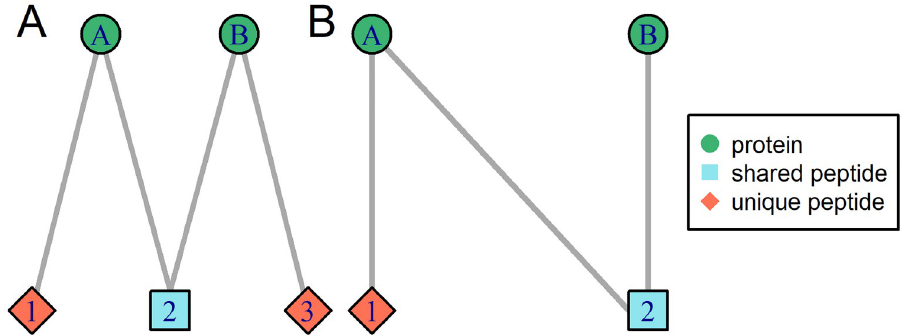
Fig 1. Examples of bipartite graphs depicting protein-peptide relationships. Protein nodes are shown as green circles and peptide nodes as red diamonds (unique to a protein node) or blue squares (shared between protein nodes). Each node may represent multiple protein accessions or peptide sequences. Unique peptide nodes are defined as nodes belonging to only one protein node, which may contain several protein accessions. Shared peptide nodes belong to at least two distinct protein